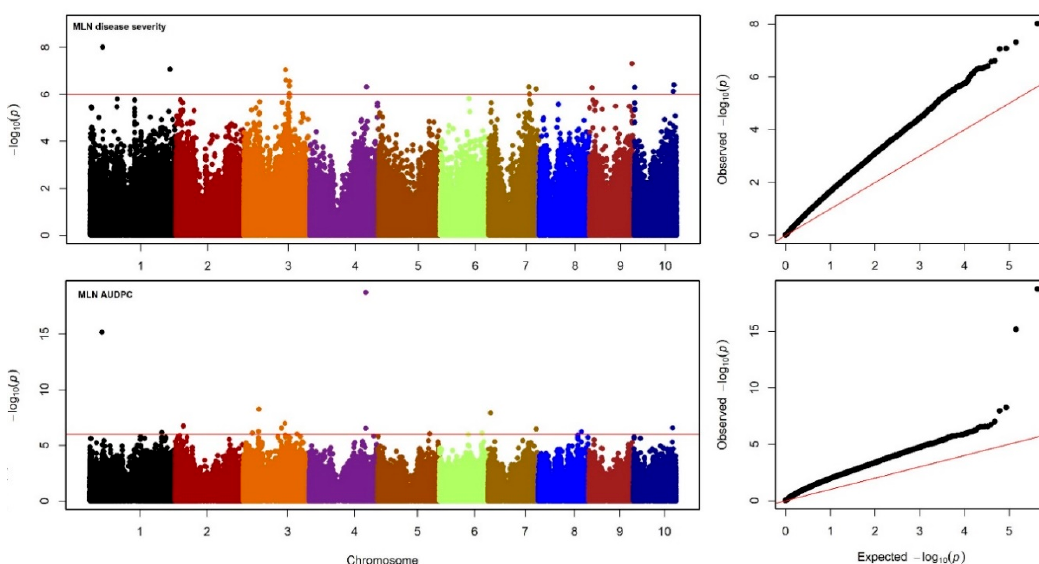
Figure 4. Manhattan and Q-Q plots for the GWAS of MLN for disease severity and the AUDPC value. The dashed horizontal line in Manhattan plots depicts the significance threshold ( p = 1 × 10 − 7 ). The x -axis indicates the SNP location along the 10 chromosomes, separated by di ff erent colors. the red line in the Q-Q plots depicts the line of best fit whereby for both traits the plot of expected − log 10 ( p ) against observed − log 10 ( p ) falls above the line of best fir.